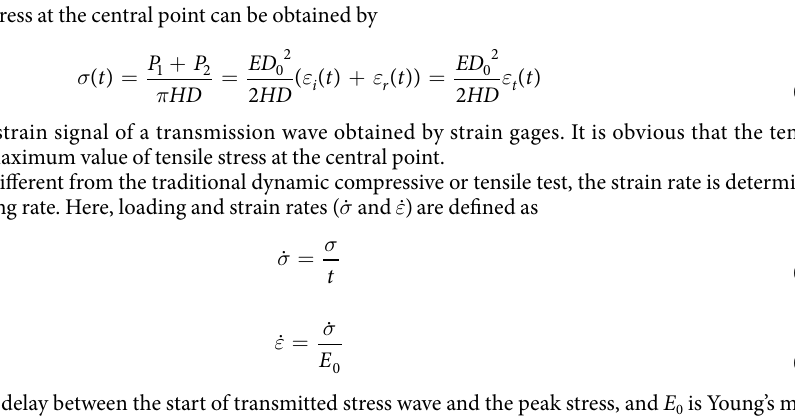
in x-z plane of specimens with thickness of 30 and 55 mm, x